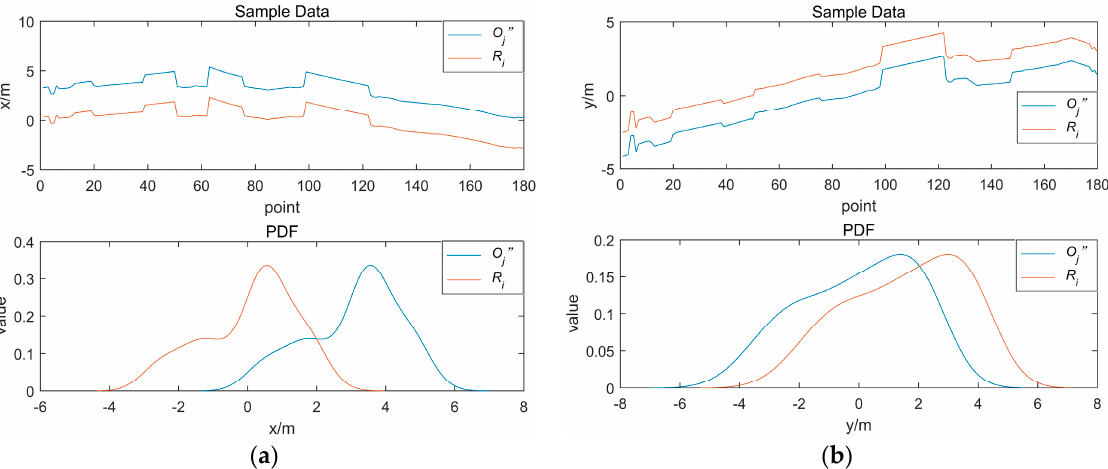
Figure 11. Sample data distribution and probability density function of data sets 𝑂 (cid:3037)’’ and 𝑅 (cid:3036) : ( a ) x-axis; ( b ) y-axis.